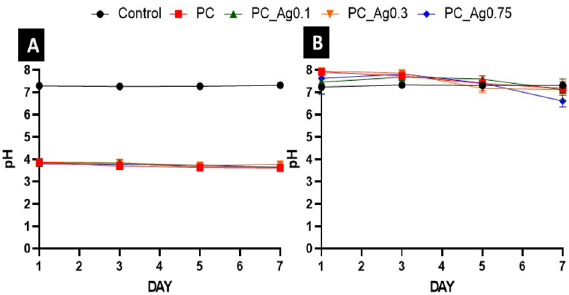
Figure 3. pH analysis of all dissolved in deionised water ( A ) and cell medium ( B ) over 7 days. Error bars represent the SD ± mean of two biological replicates. PBS was used as a control for this